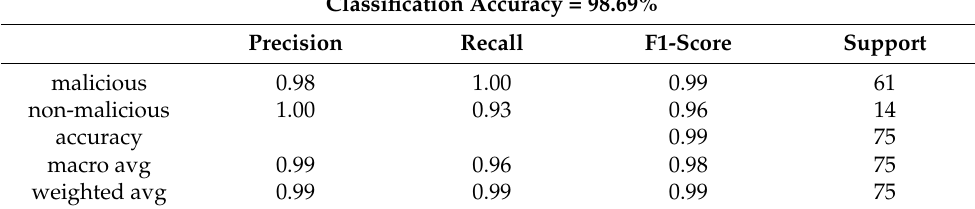
Figure A3. DT classifier model summary with a confusion matrix. Table A3. KNN classifier.